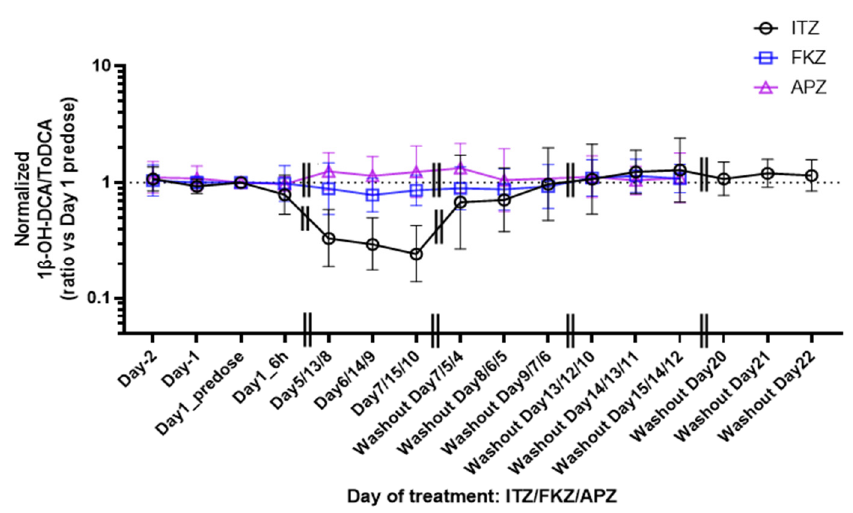
Figure 2. Plot of changes of the urinary metabolic ratio of 1 β -OH-DCA/ToDCA from baseline in healthy male volunteers before, during, and after the repeated administration of ITZ (100 mg od; n = 10), FKZ (50 mg od; n = 9) and APZ (1 mg od; n = 8).